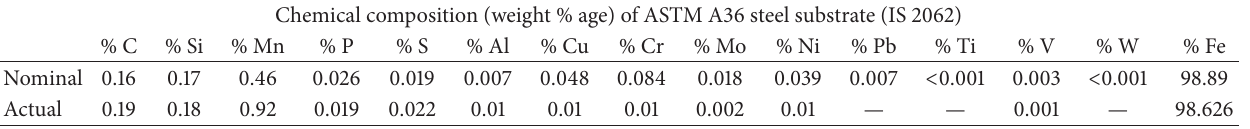
Table 1: Nominal and actual percentage composition of ASTM A36 steel.